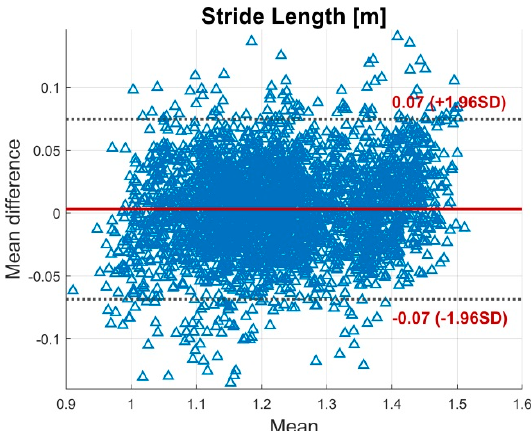
Figure A8. BA plot for the stride length. The plot contains all calculated data points of all subjects. The solid line indicates the mean difference. The dashed lines indicate the LoA (95% CI of the mean difference).